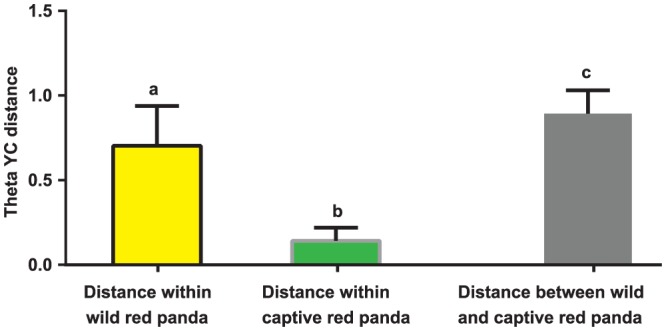
Variation of the Theta YC distances within and between the wild and captive red panda.The average Theta YC distance within the wild red panda group is significantly greater than that within the captive red panda group and smaller than the distance between the two groups as indicated by different lowercase letters (P<0.001, Kruskal-Wallis test with Dunn's correction).